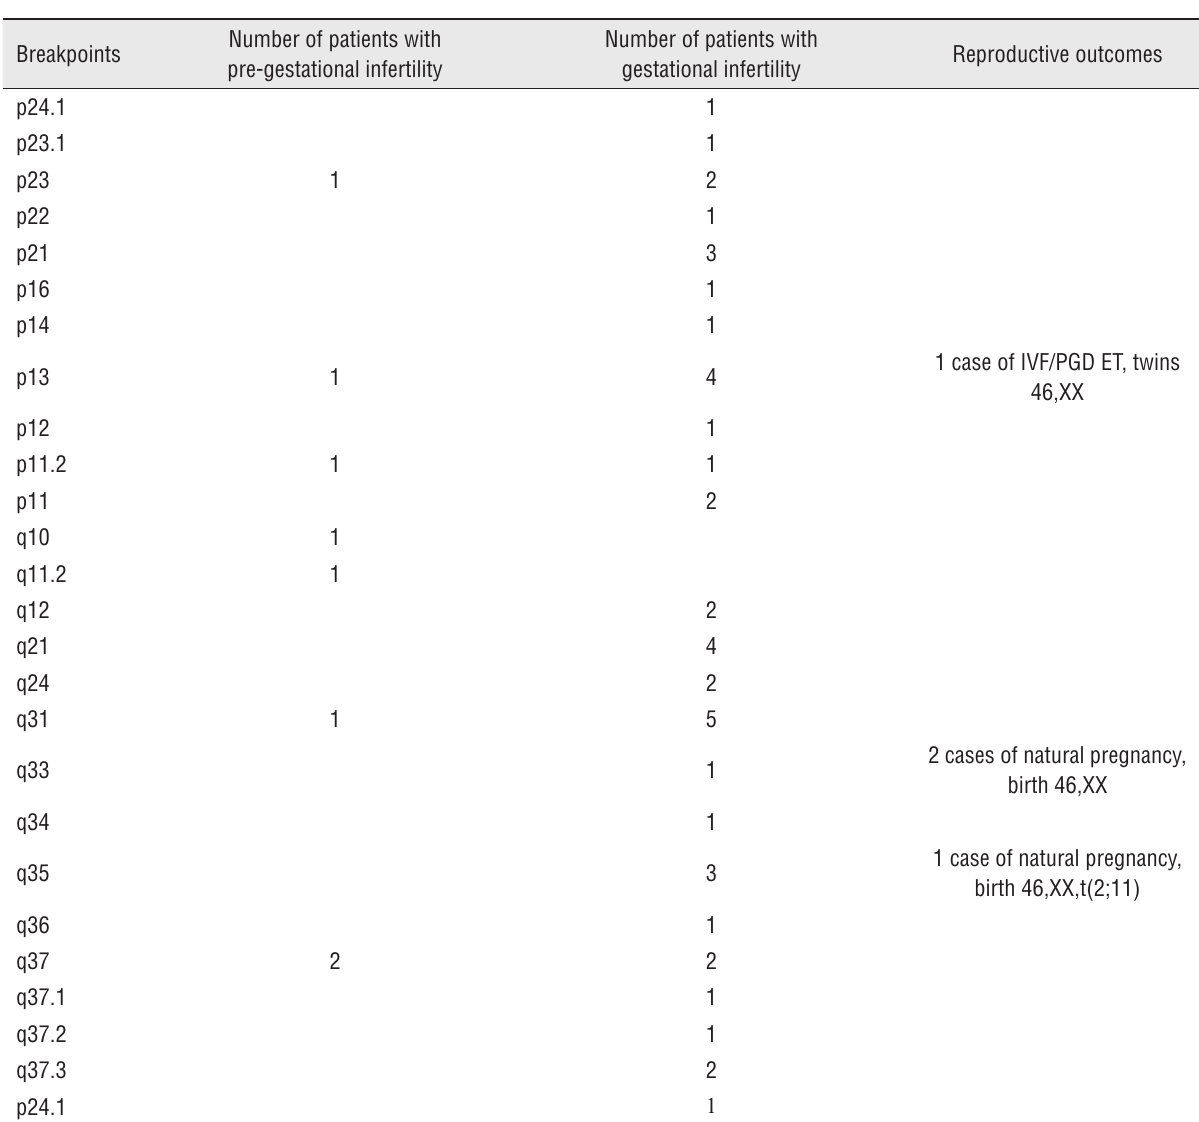
Table 3 - Incidence of breakpoints on chromosome